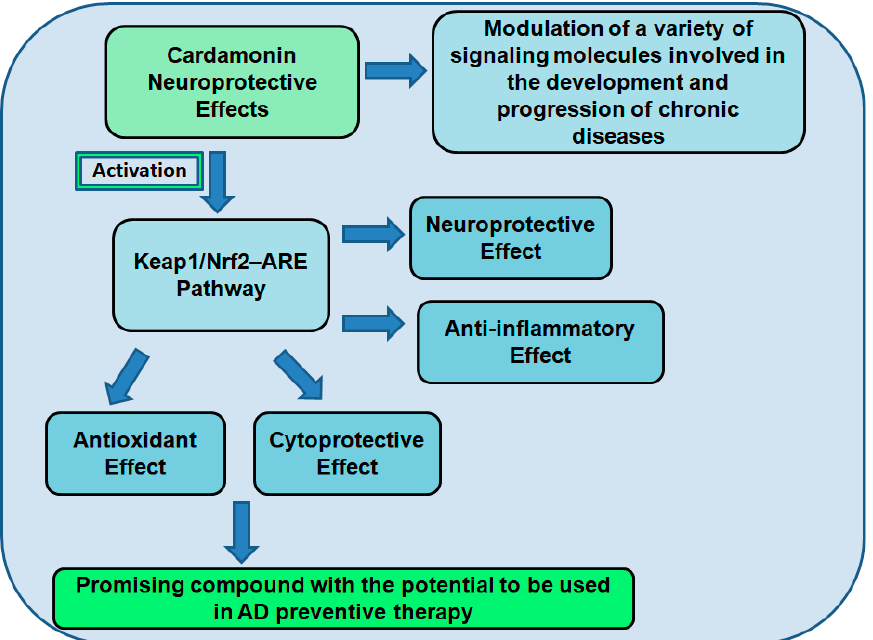
Figure 4. Summary of CD’s neuroprotective effects. Studies show that CD modulates signaling molecules including transcription factors, cytokines, protein and genes. CD also activates Nrf2 signaling inducing antioxidant, anti-inflammatory, and cytoprotective effects, indicating its potential as a cytoprotective therapeutic compound against AD.